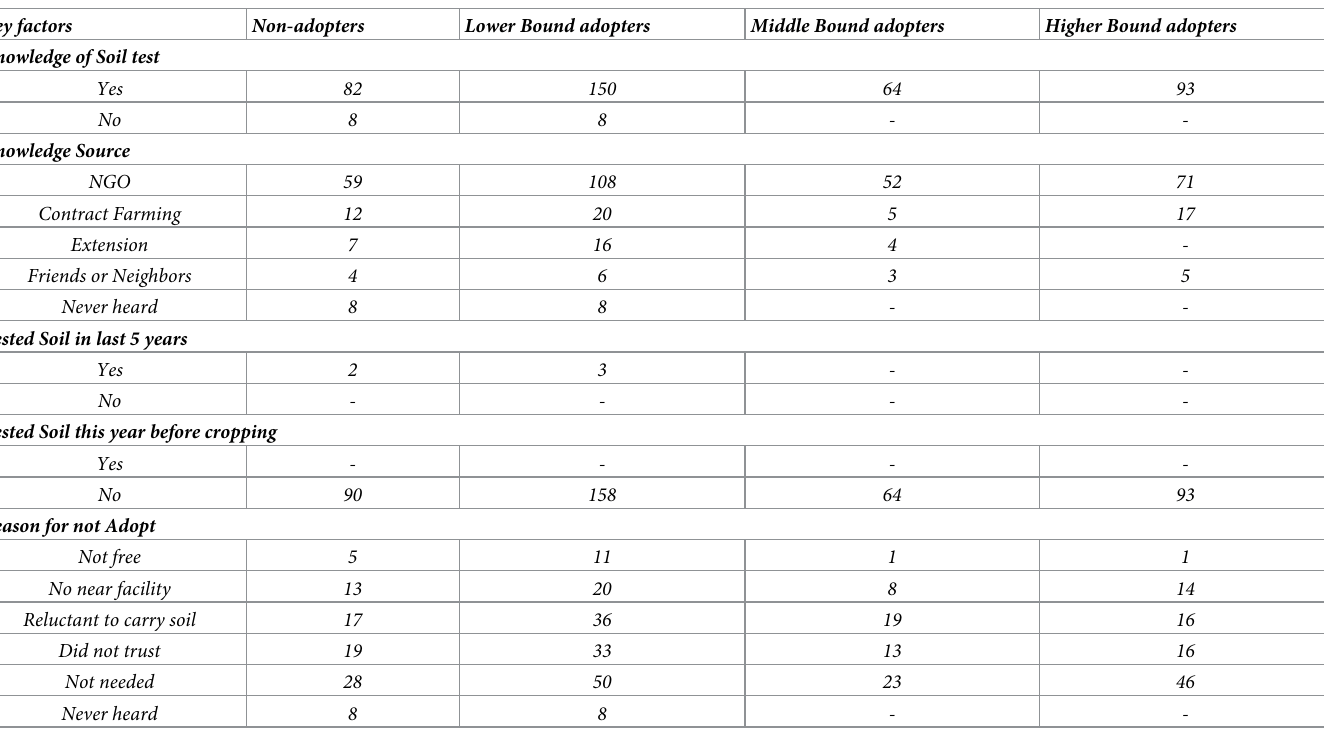
Table 4. Respondents’ soil testing status, knowledge and sentiments towards non-adoptions. Key